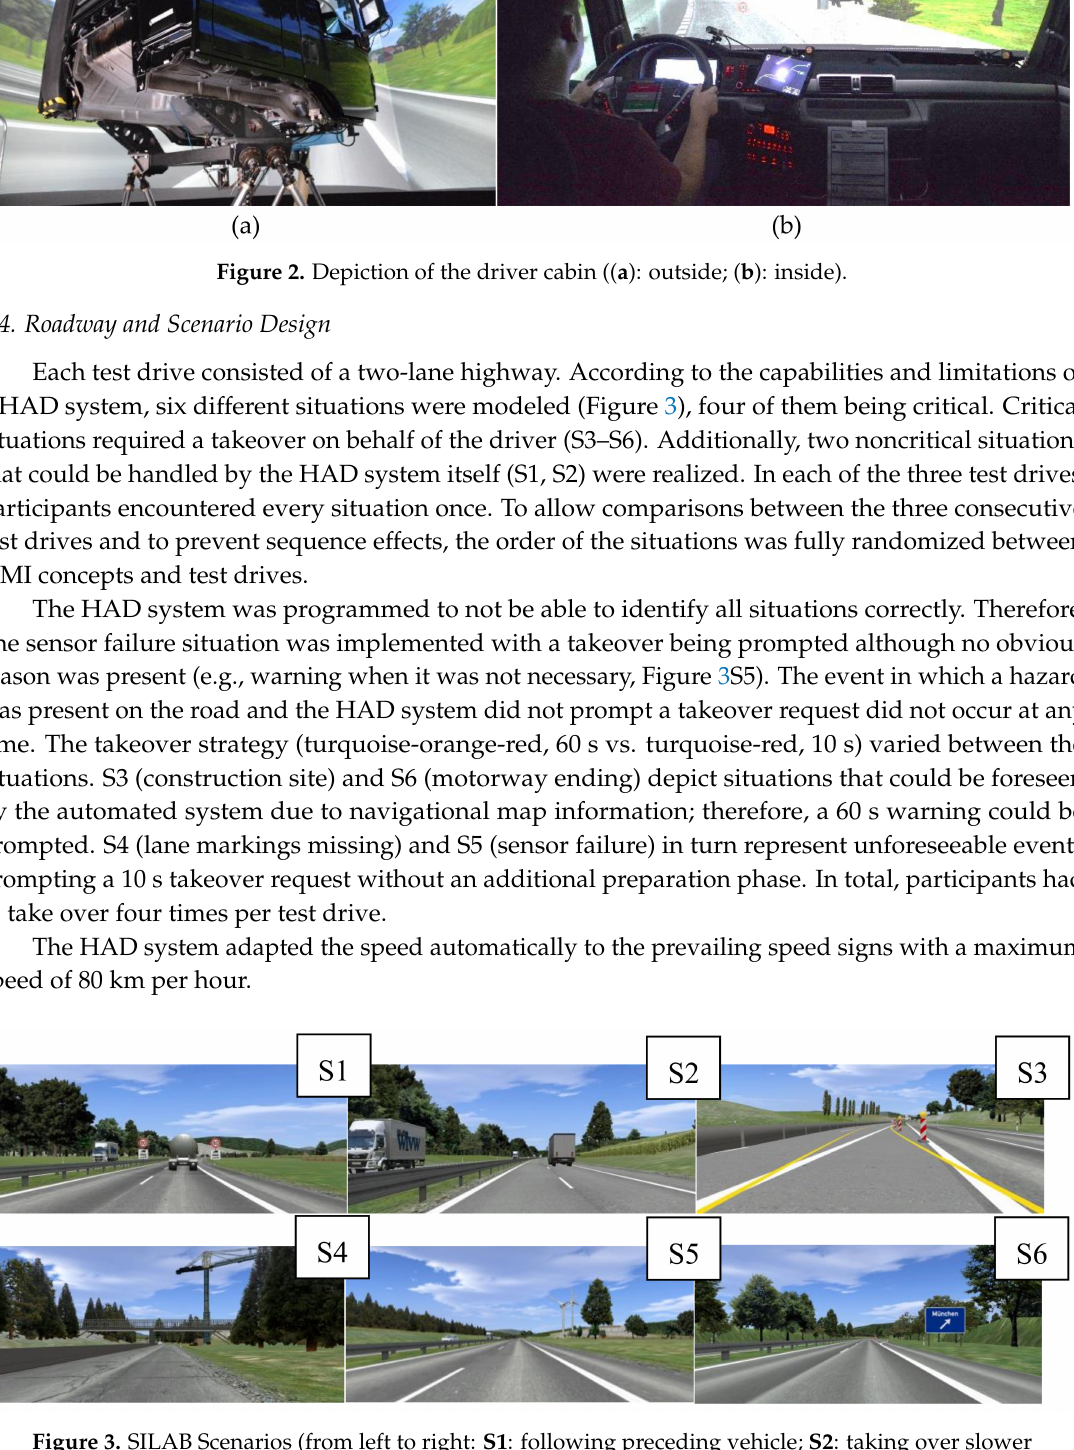
Figure 3. SILAB Scenarios (from left to right: S1 : following preceding vehicle; S2 : taking over slower vehicle; S3 : construction site, S4 : missing lane marking; S5 : sensor failure; S6 : motorway